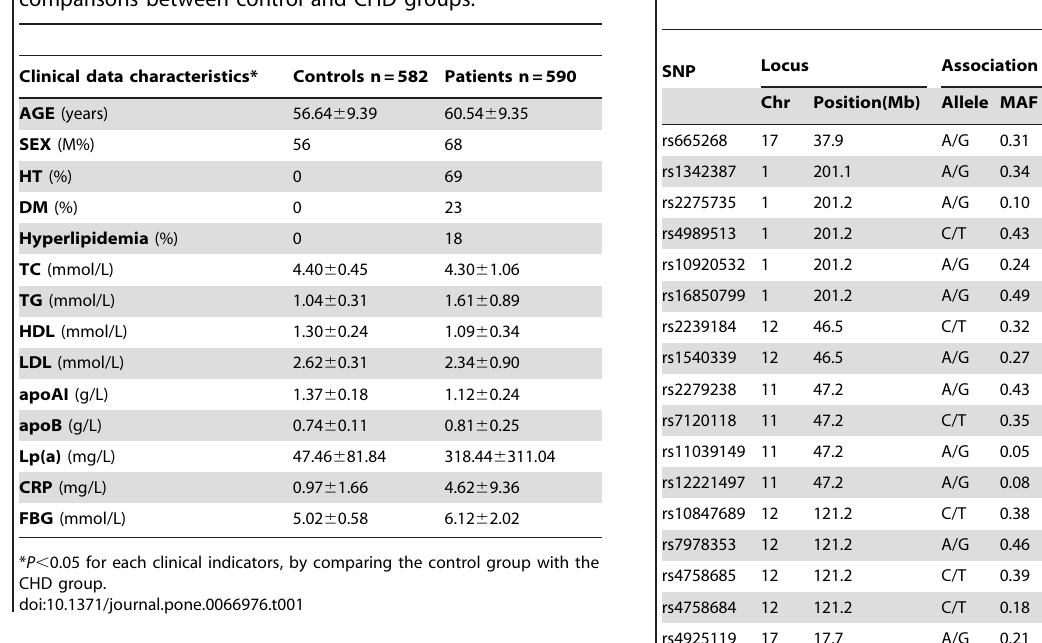
Table 2. The 1 st stage association of 21 SNPs with